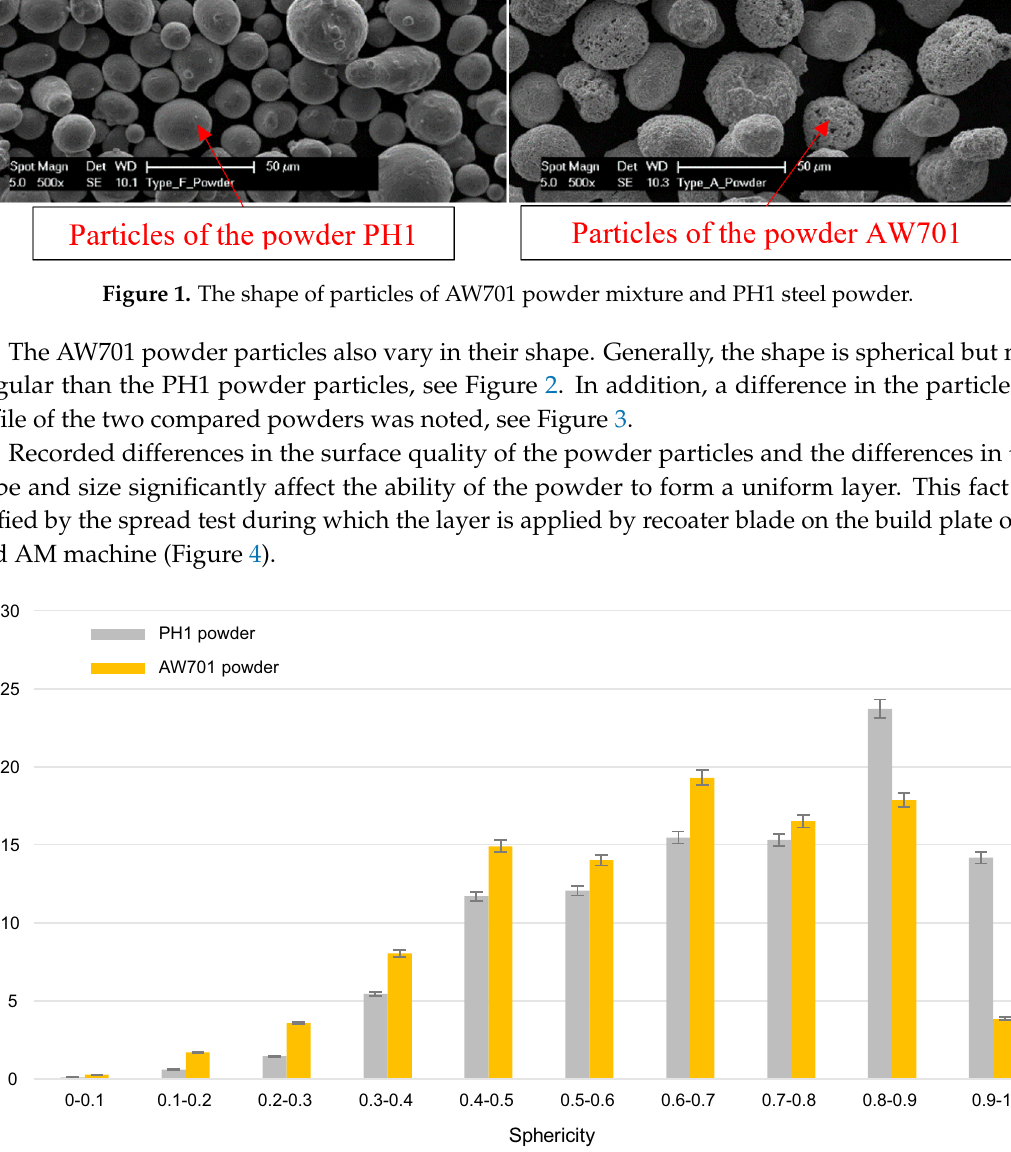
Figure 2. Sphericity analysis for the two studied powders